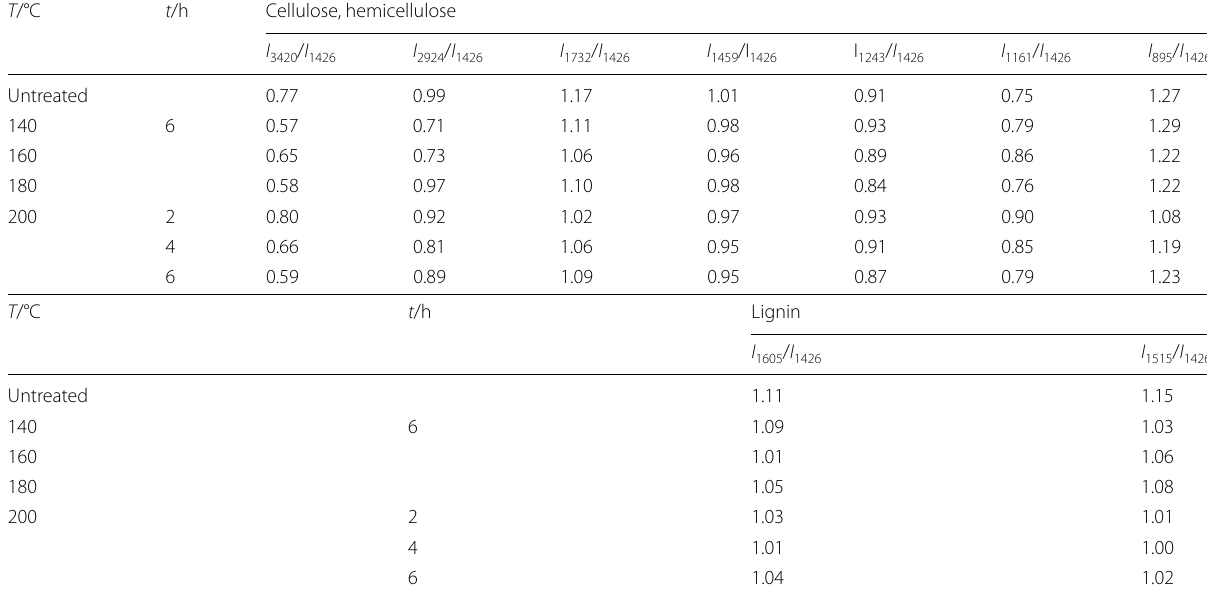
Table 4 Relative intensity of absorption peak of untreated and oil heat-treated bamboo samples T /°C